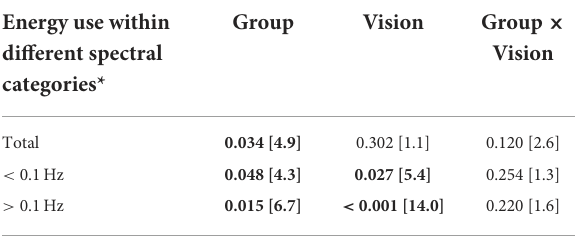
TABLE 5 GLM ANOVA analysis of effects of Group and Vision on the stability during quiet